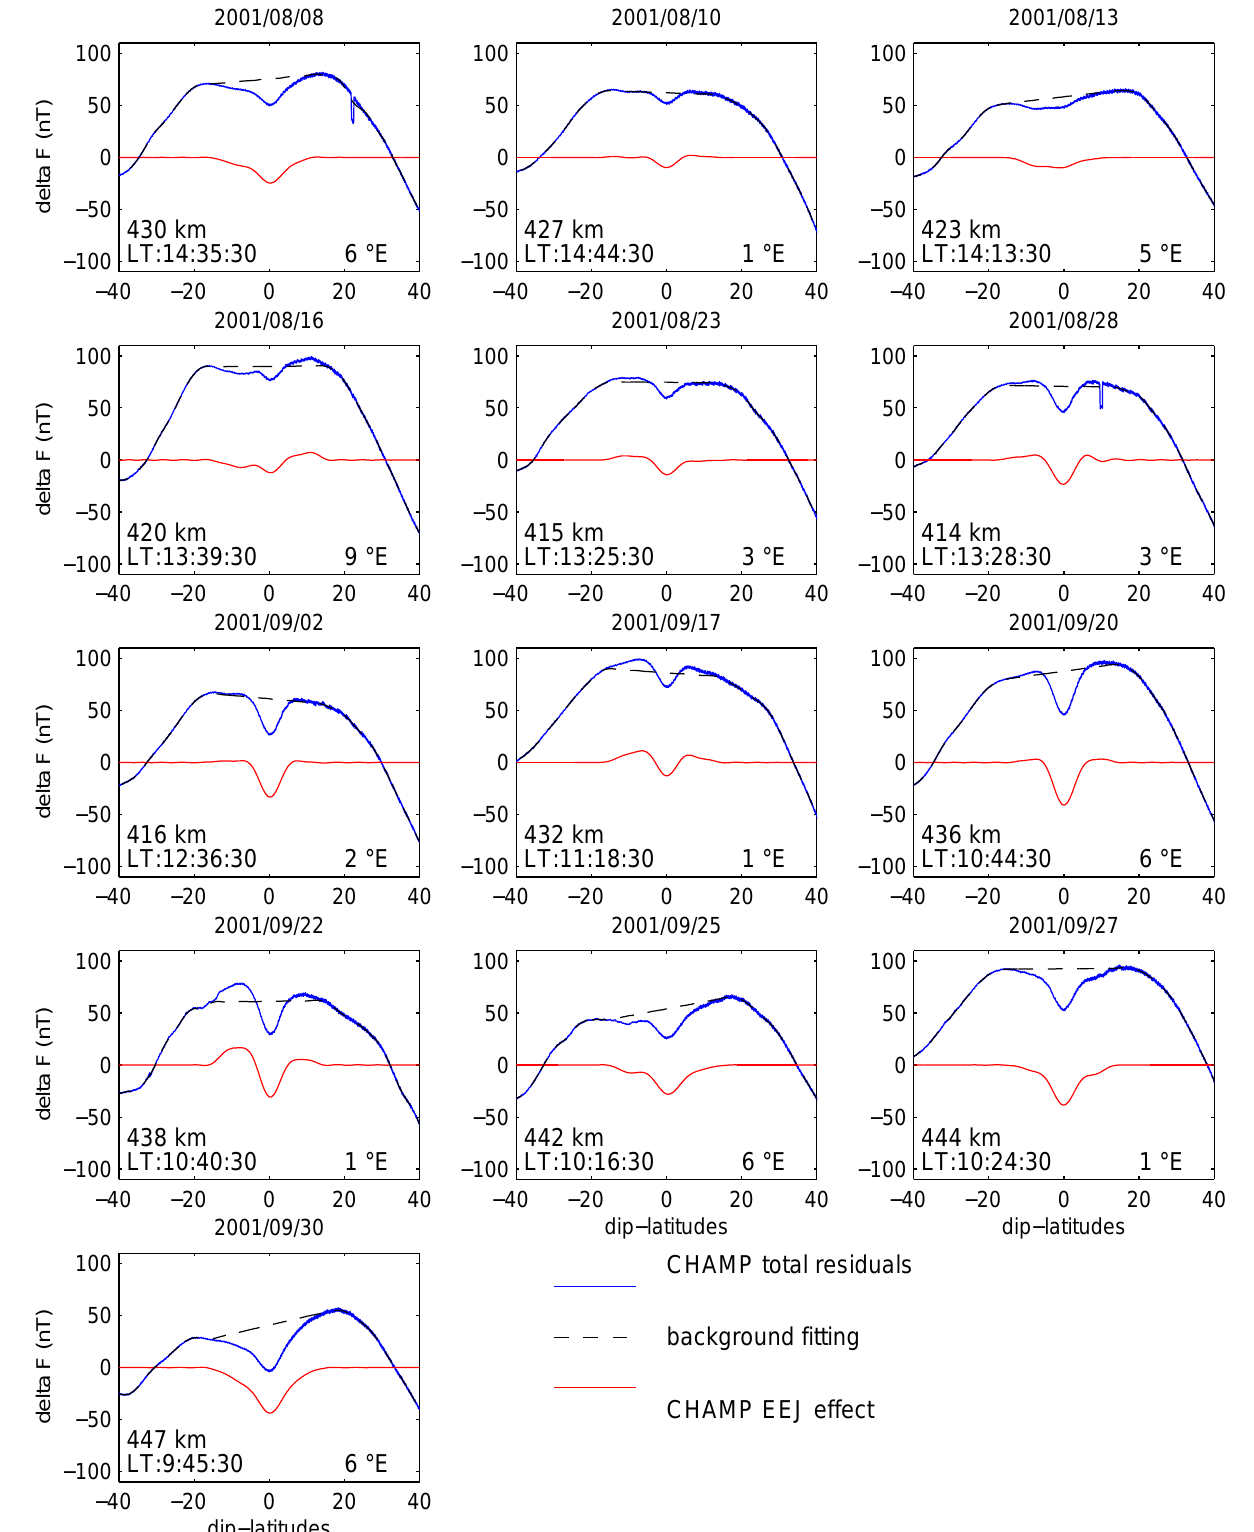
Fig. 1. Isolation of the EEJ magnetic signature from CHAMP satellite total residuals. The total magnetic residuals (blue solid lines) from CHAMP data have been extracted from the total field using the main field IGRF2000 model for the epoch 2001.5. To isolate the EEJ effect (red solid line), the background shape has been fitted using a polynomial function (dashed black line), and subtracted from the total